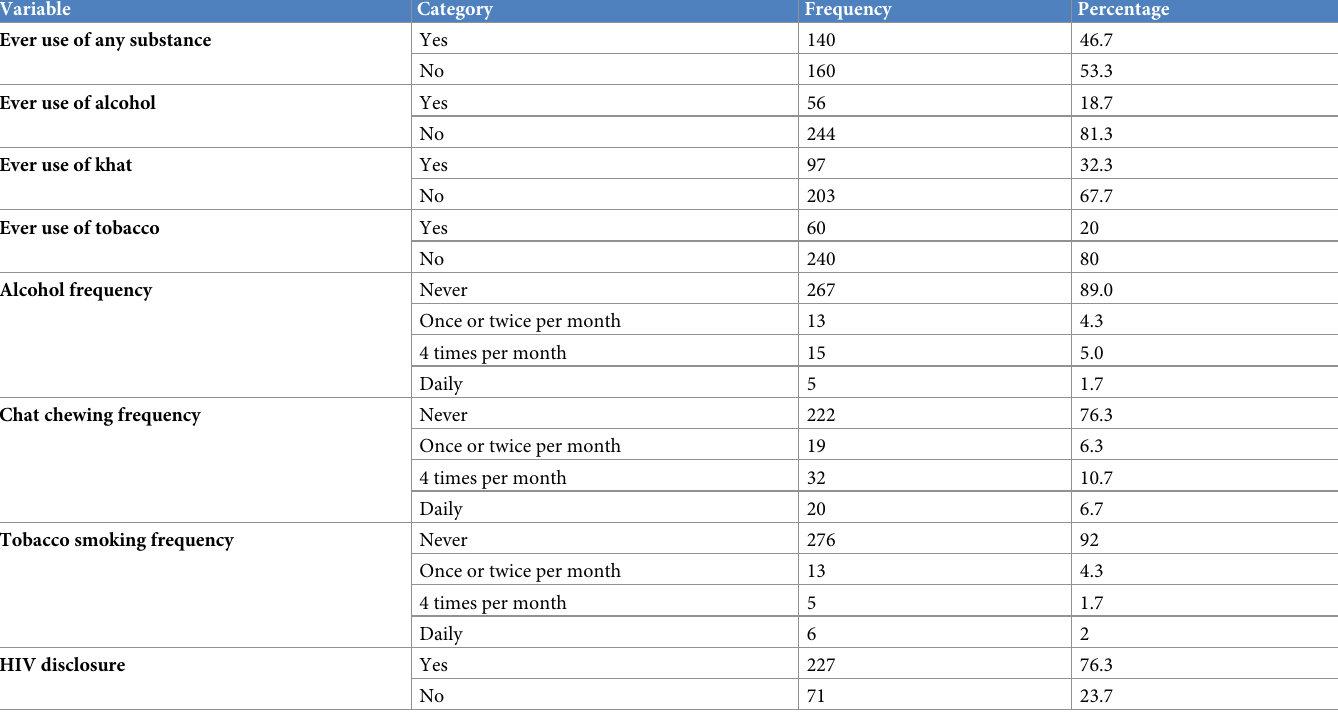
Table 2. Behavioral characteristics of respondents with quality of life among PLHIV in Jimma zone public hospitals, South-west